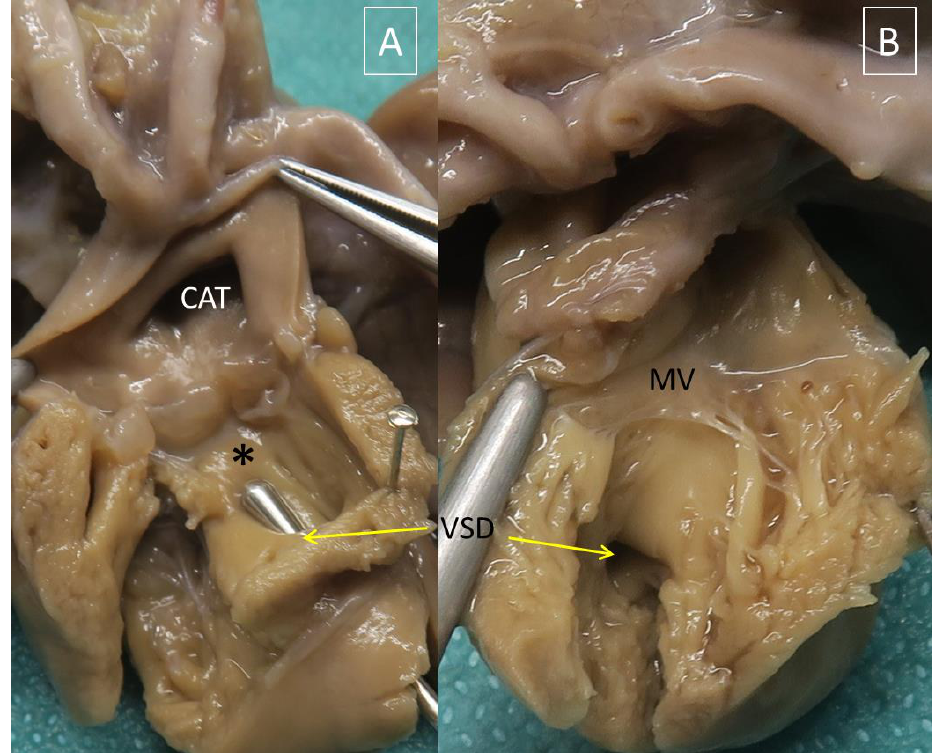
Figure 4. Heart specimen with common arterial trunk type 4, aortic coarctation and hypoplastic left ventricle (Table 3, Case 35). ( A ): view from the right ventricle. The common arterial trunk (CAT) is entirely above the right ventricle and there is a subarterial conus (asterisk). ( B ): view from the left ventricle. There is a large mid-muscular ventricular septal defect (yellow arrow).